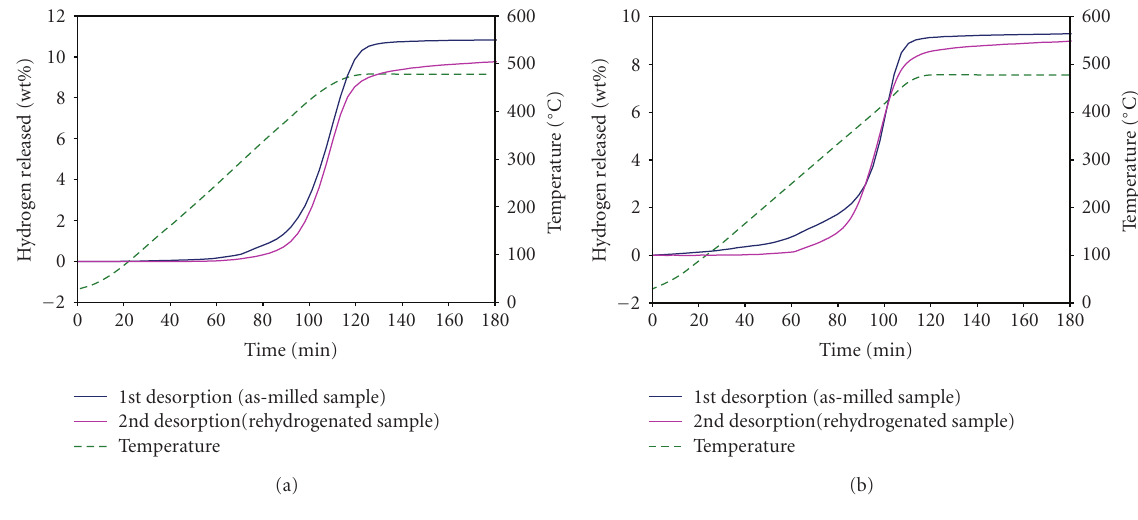
Figure 4: TPD of the as-milled and rehydrogenated LiBH 4 /CaH 2 mixture with (a) 4mol% and (b) 25mol% of TiCl 3 additive.